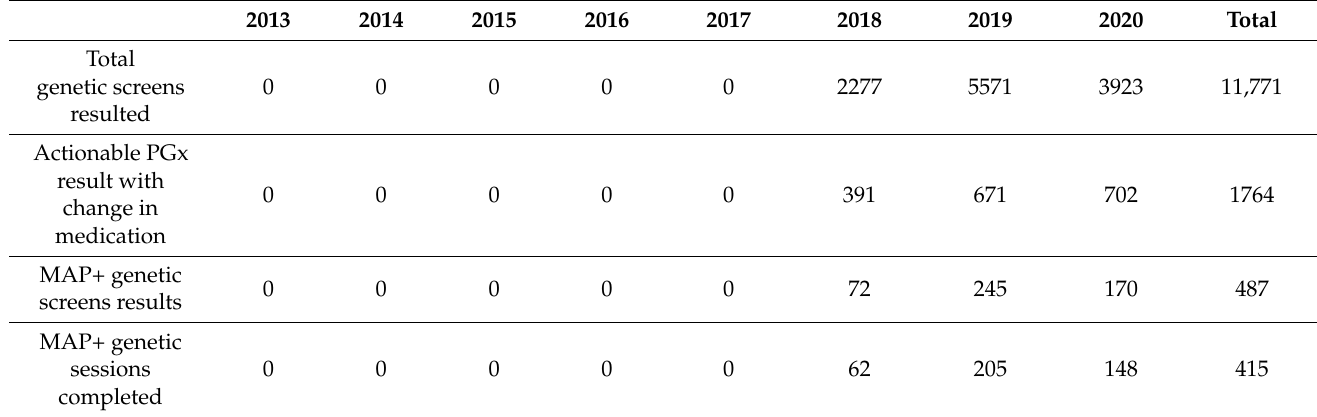
Table 2. Uptake of the genetic screen and genetic services through the precision medicine program over time.